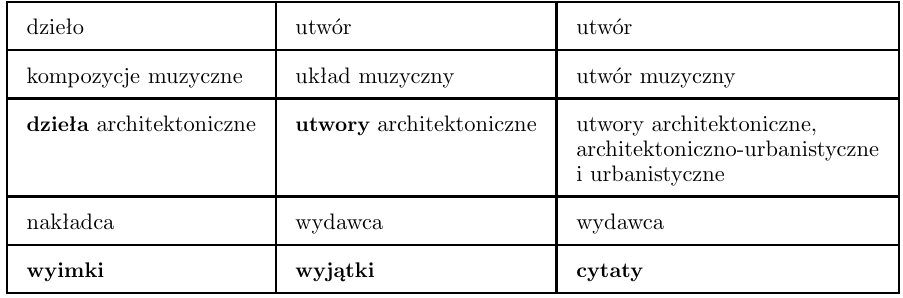
The juxtaposition of diachronic changes in terminology resulting in the emergence of synonyms in the Polish language of